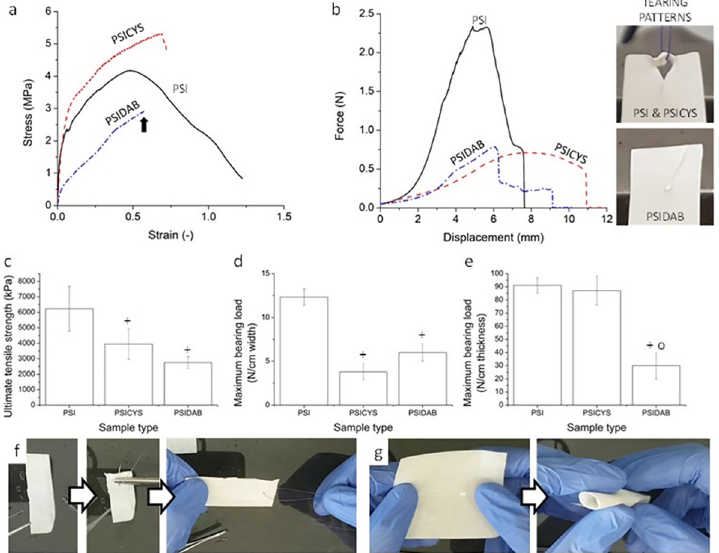
Fig 4. Examples for stress-strain curves of PSI, PSICYS and PSIDAB samples (black arrow indicates the tearing point of PSIDAB) (a), examples for force-displacement curves obtained in single interrupted suture model tests (b); ultimate tensile strengths (c), maximum bearing loads (d, e) of the samples; sutured PSIDAB sample (f), rolled up PSIDAB sample for e.g., laparoscopy (g). “+” means significant (p = 0.05) from PSI and “o” means significant difference from